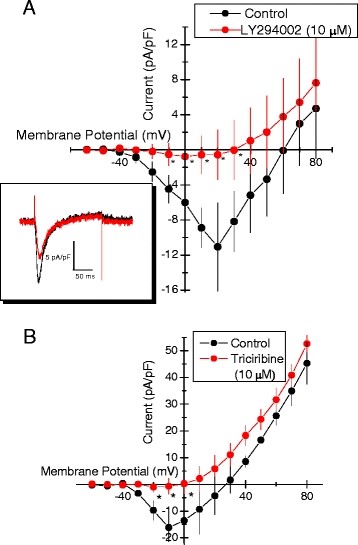
Pharmacologic inhibition of phosphoinositide-3-kinase (PI3K) and Akt-PKB decrease Ca
2+
current in HL-1 cell mouse cardiomyocytes.
A
. Effect of LY294002 (10 μM) on I/V plot of Ca2+ current compared with control (mean ± SEM; n = 3). Holding potential = −50 mV. Inset. Overlay of currents recorded in same cell
before
 and
after
 LY294002 (10 μM) during a voltage step from −50 mV (HP) to 0 mV. Baseline current at −50 mV prior to voltage step to 0 mV was 0 nA.
B
. Effect of triciribine (10 μM) on Ca2+ current compared with control (mean ± SEM; n = 3). Holding potential = −50 mV.